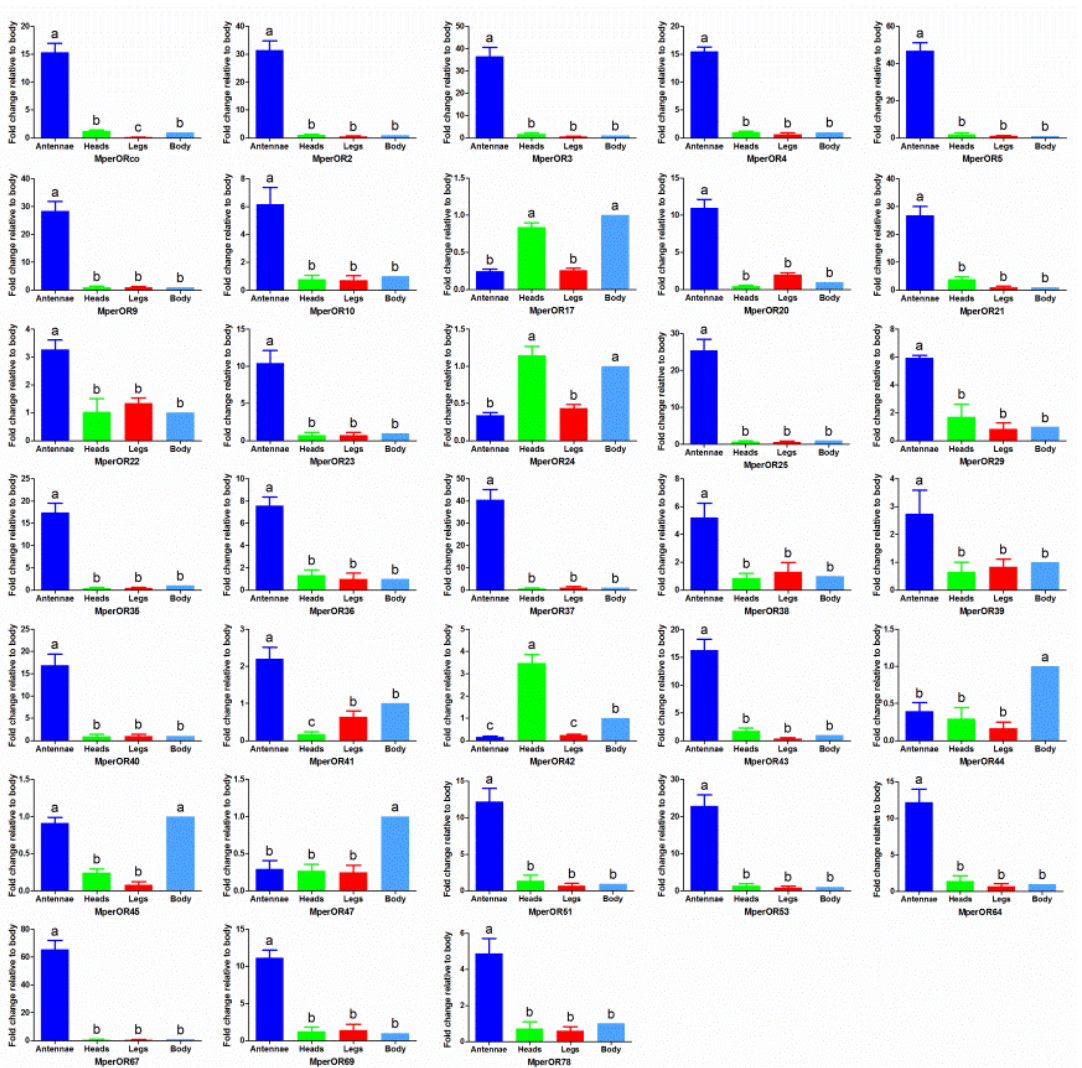
Figure 4. The OR transcript levels of M. persicae in different tissues assessed by RT-qPCR. The error bars present the standard error, and the different letters (a, b, c) indicate significant differences ( p < 0.05). This figure was presented using GAPDH as the reference gene to normalize the target gene expression and correct sample-to-sample variation; similar results were also obtained with β -actin as the reference gene.